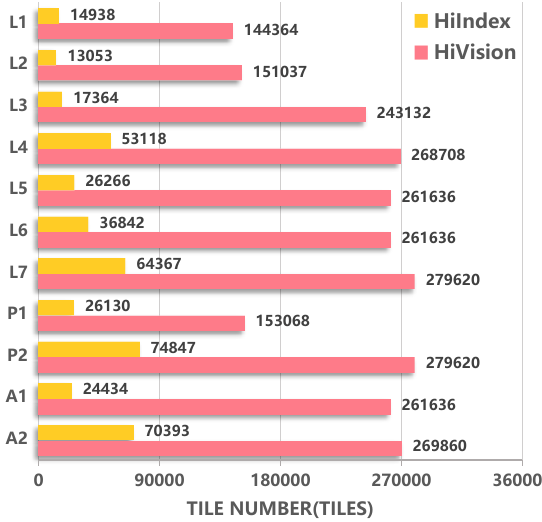
Figure 10. Number of tiles to draw to generate tiles in zoom levels 1, 3, 5, 7, and